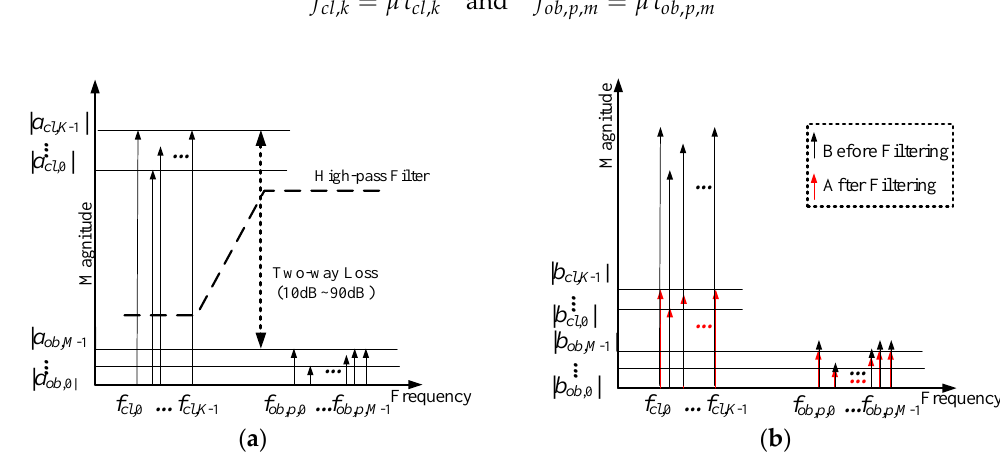
Figure 2. Illustration of high-pass filtering, ( a ) Beat signals before filtering, ( b ) Filtered beat signals. The magnitudes | a cl,k | and | a ob,m | in Figure 2a are replaced with | b cl,k | and | b ob,m | in Figure 2b to describe the filtered beat signals. Since a high-pass filter is used for wall clutter rejection, | a cl,k | ≫ | b cl,k | and | a ob,m | ≈ | b ob,m |. DOA can be ignored as in Equation (3), Equation (5), and Equation (8). We only considered it in RTD as in Equation